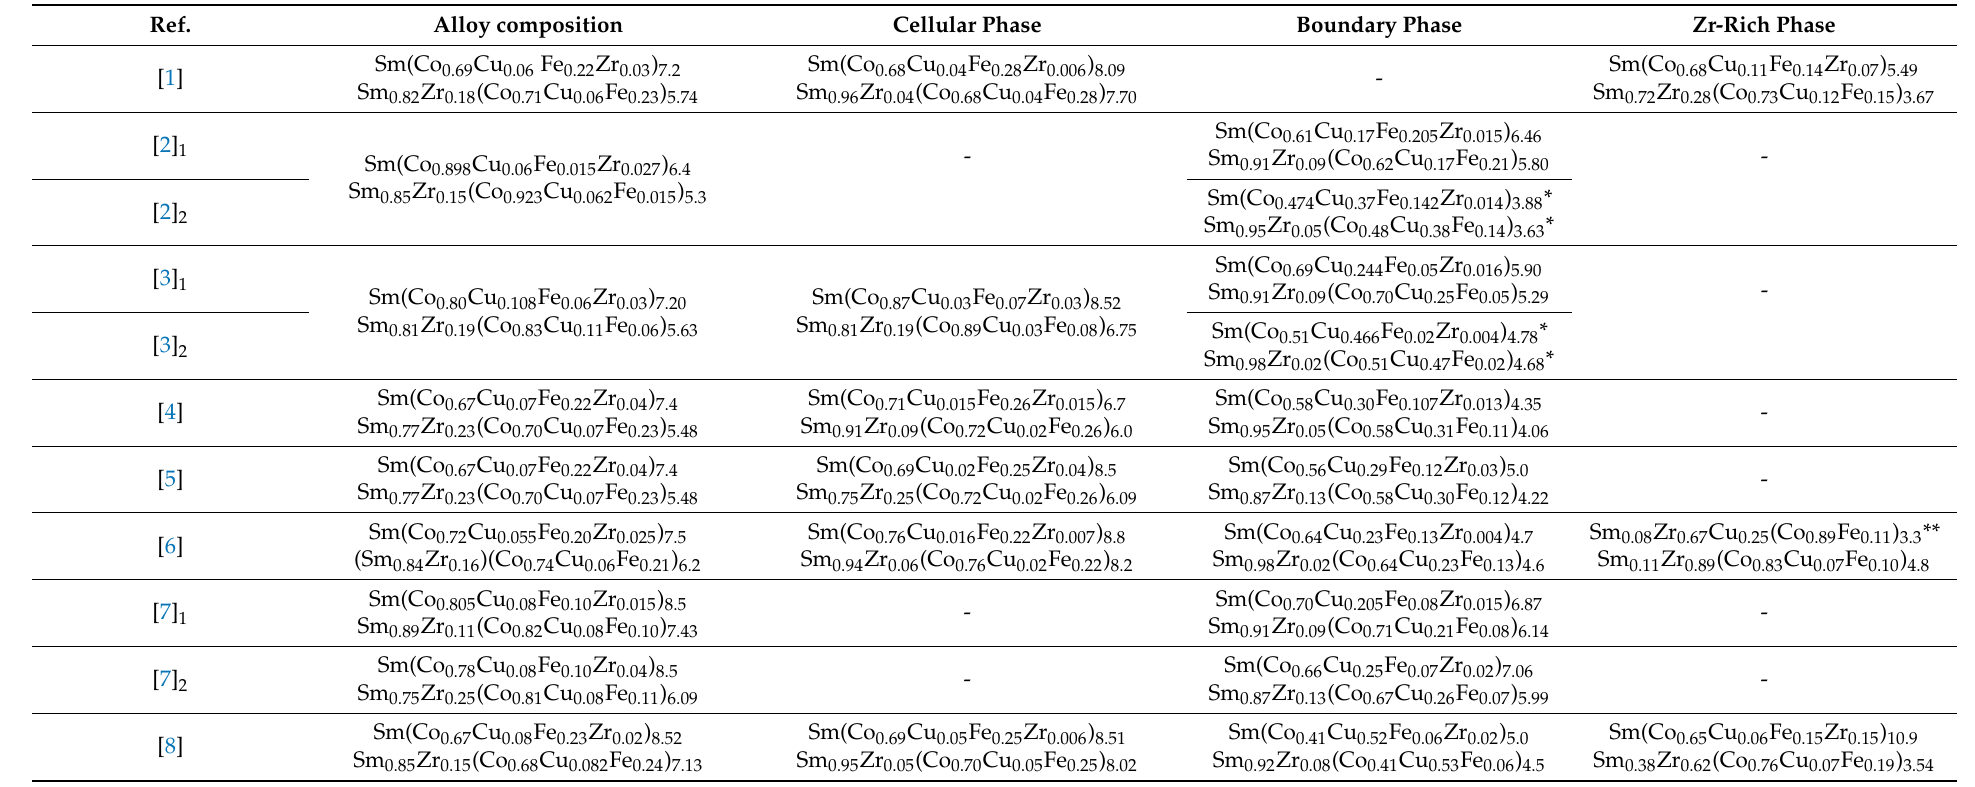
Table 3. Experimental data for the integral compositions and individual phases of the high-coercivity (Sm,Zr)(Co,Cu,Fe)z alloys [1–8].